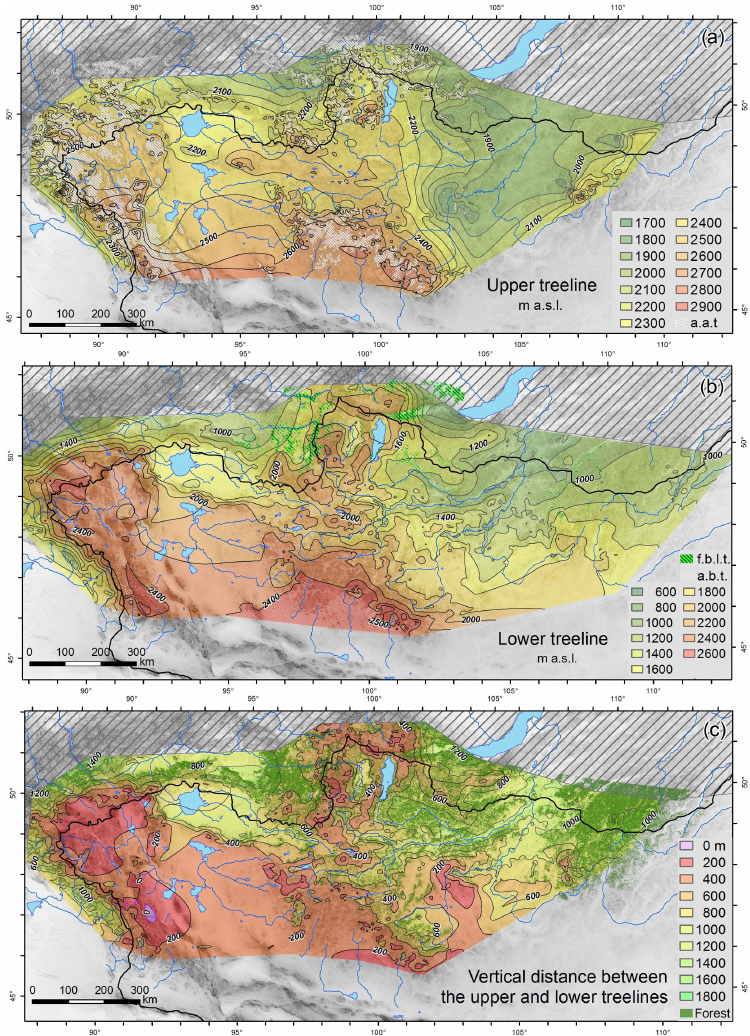
Figure 4. Treeline distribution maps of Mongolia: (a) upper treeline, (b) lower treeline, (c) vertical distance between upper and lower treeline (a.a.t. = area above the upper treeline, a.b.t. = area beneath the lower treeline, f.b.l.t. = forest below the lower treeline, a.s.l. = above sea